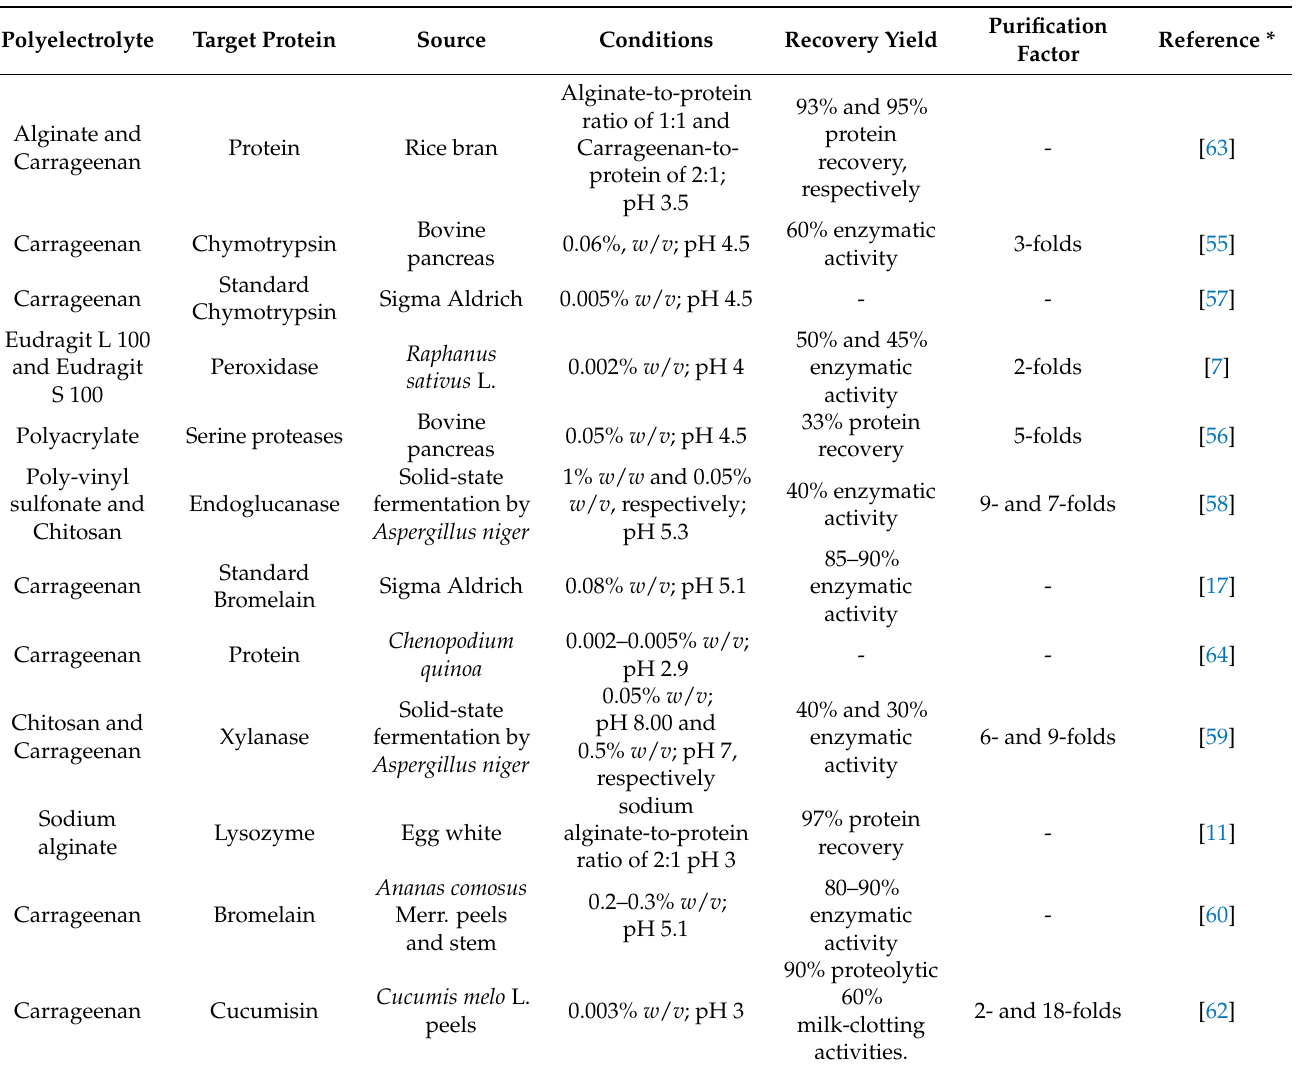
Table 1. Spectrum of protein recovery from different sources by polyelectrolyte precipitation (natural vs